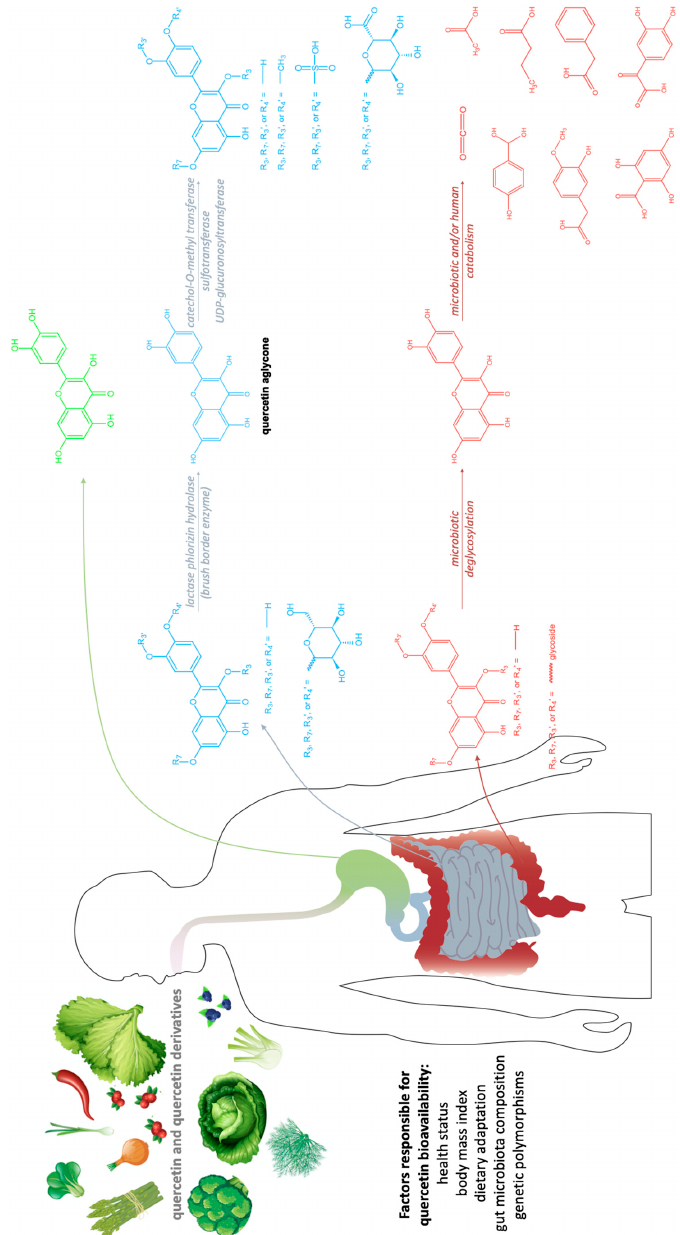
Figure 3. Quercetin metabolism in the gastro-intestinal tract. Green—stomach absorption; blue— small intestine absorption; red—large bowel